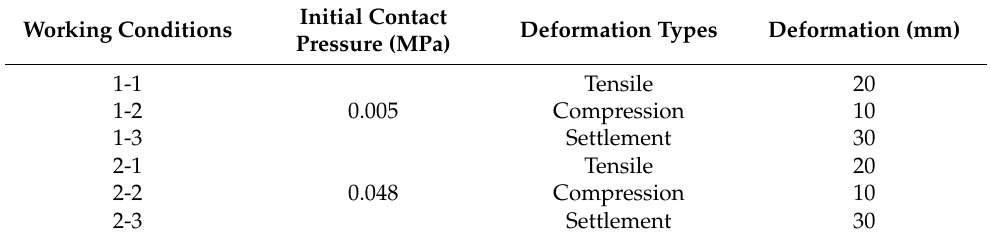
Table 3. Working conditions of finite element analysis. Working